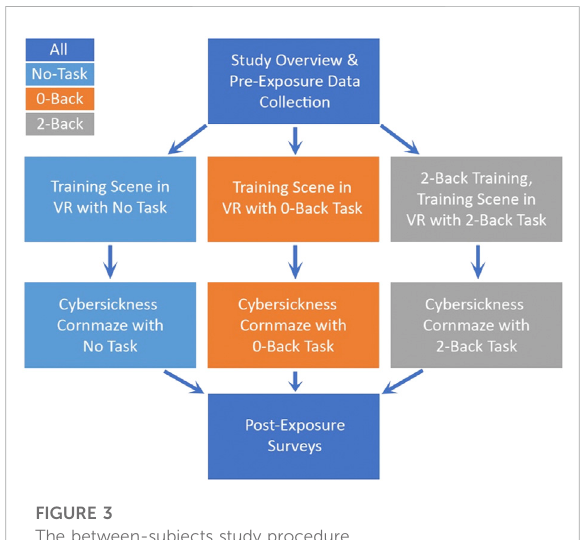
FIGURE 3 The between-subjects study